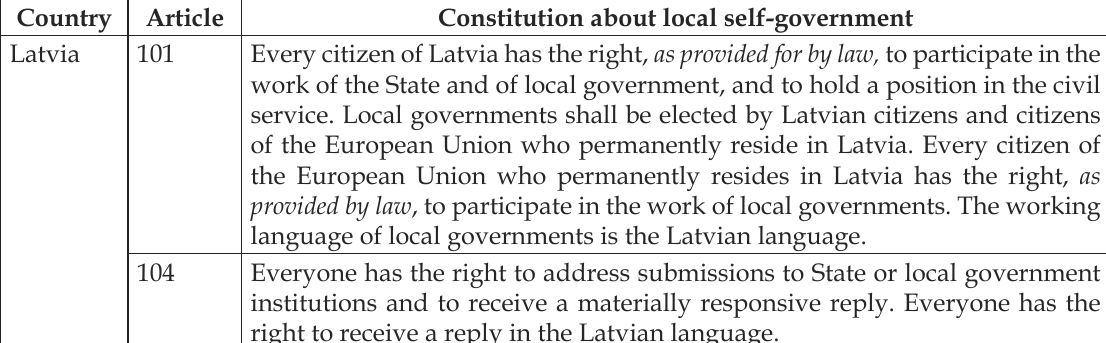
Tab. 1. Concepts of local self-government in the Baltic States